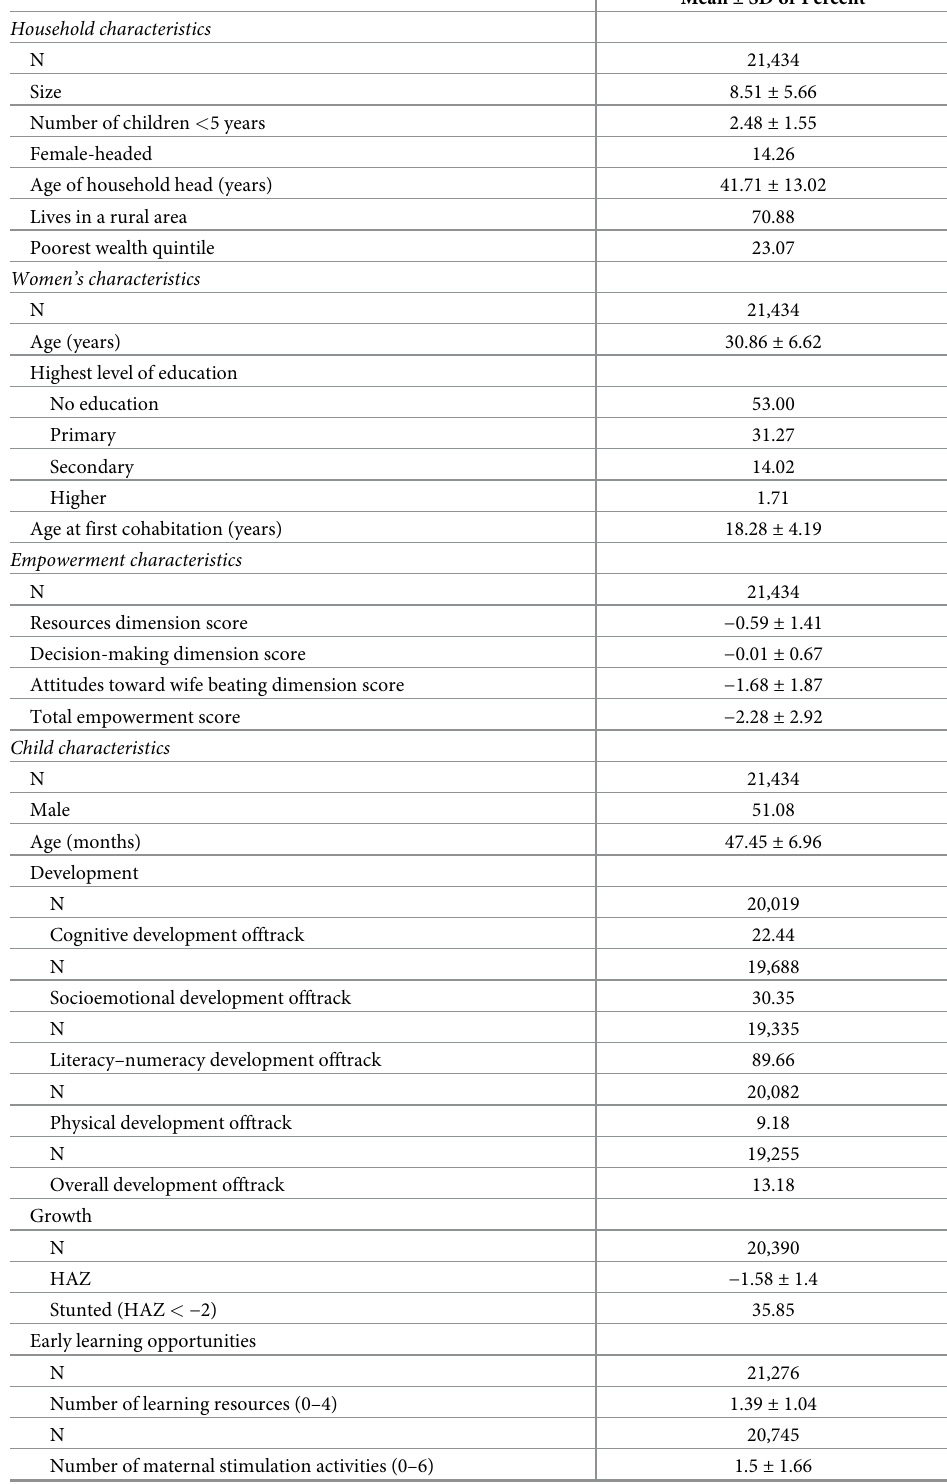
Table 2. Characteristics of the women and children included in the analysis